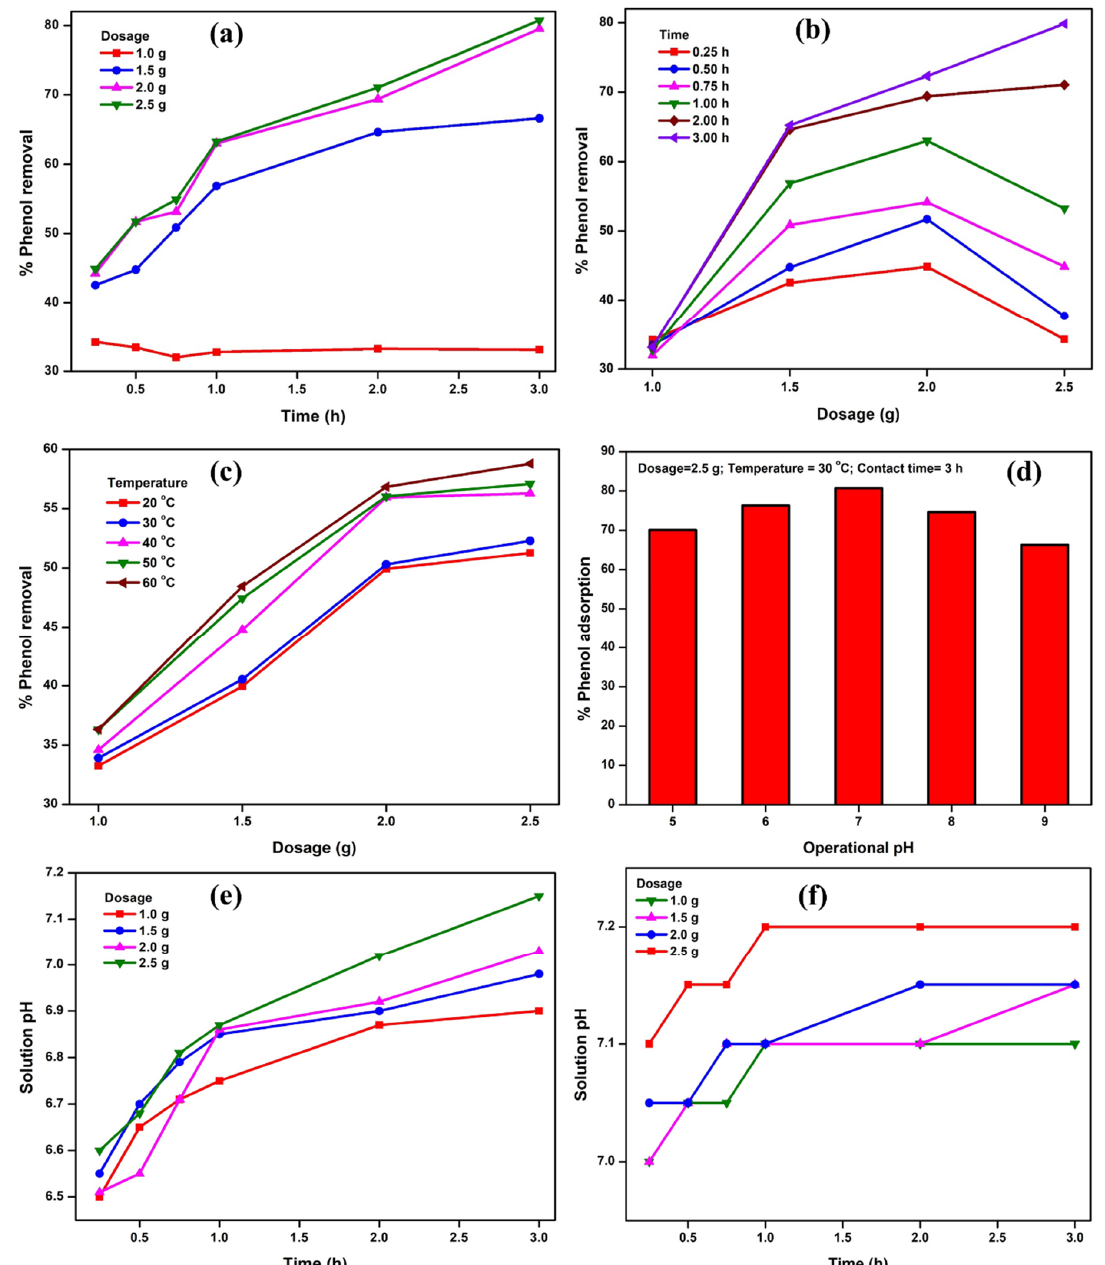
Figure 2. Effect of ( a ) adsorbent dosage; ( b ) contact time; ( c ) temperature and ( d ) operational pH on % phenol removal. Solution pH studies for ( e ) the adsorption system (phenol-activated carbon) and ( f ) control system (distilled-water-activated